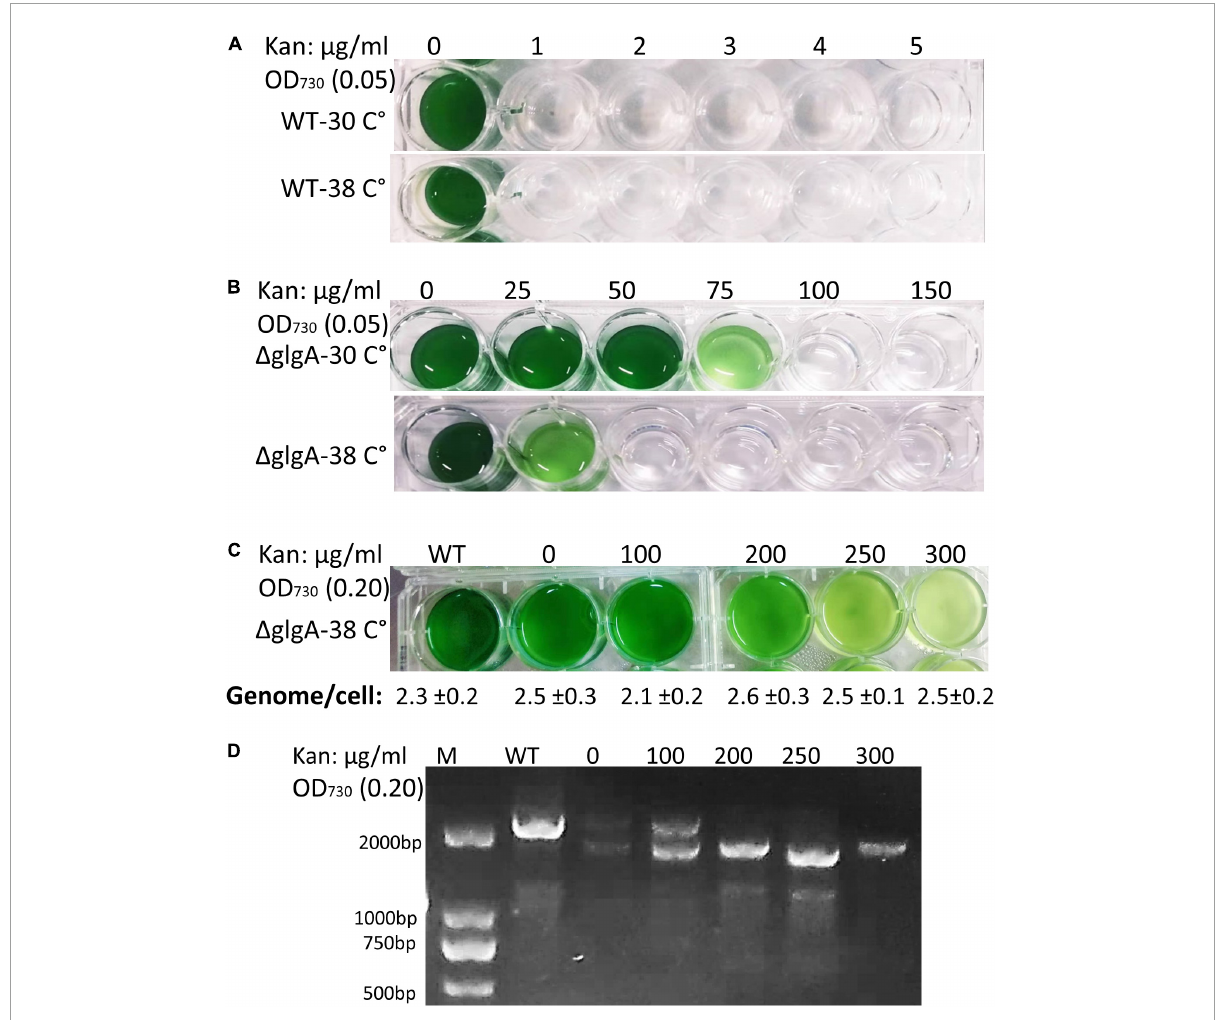
FIGURE4 Effect of different concentrations of kanamycin on the growth, genome copies, and mutation segregation in Synechococcus 7942. (A) Wild-type (WT) cells were unable to grow even at 1 µ g/ml of kan concentration at any tested temperature (30 ◦ C or 38 ◦ C). Initial OD 730 : 0.05. (B) Transformed cells ( (cid:49) glgA ) were able to grow at a higher concentration of Kan (75 µ g/ml) at 30 ◦ C, while the same number of cells was unable to tolerate Kan concentration higher than 25 µ g/ml at 38 ◦ C. Initial OD 730 : 0.05. (C) Transformed cells ( (cid:49) glgA ) grew at a higher concentration of Kan when a higher initial inoculum (OD 730 : 0.20) was used compared to initial OD 730 : 0.05. No significant effect of antibiotic concentration on genome copy number was observed. (D) A higher concentration of Kan (above 100 µ m/ml) promotes the selection of homozygous